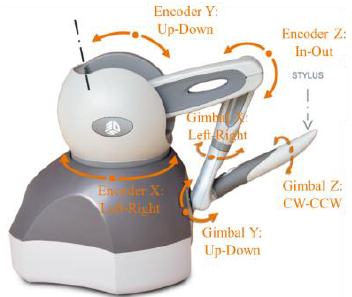
Figure 8. Master manipulator Touch.